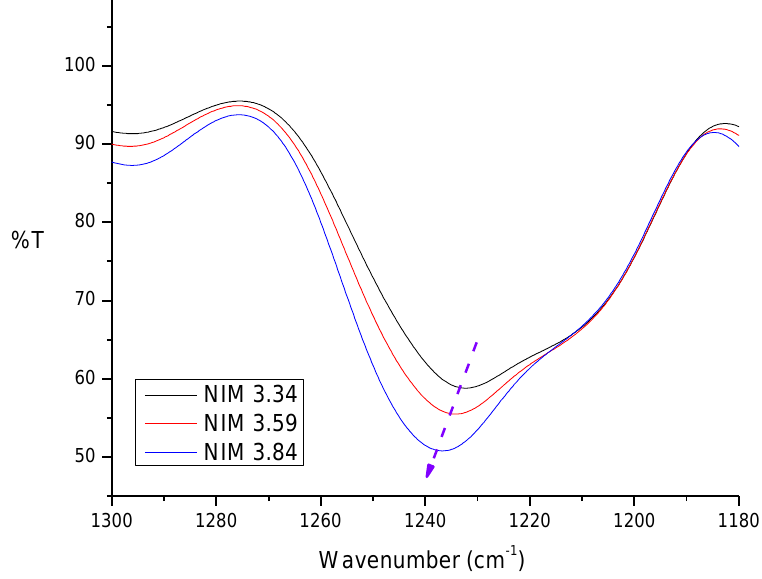
Figure 7. Comparison of membranes with variations of polysulfone addition.